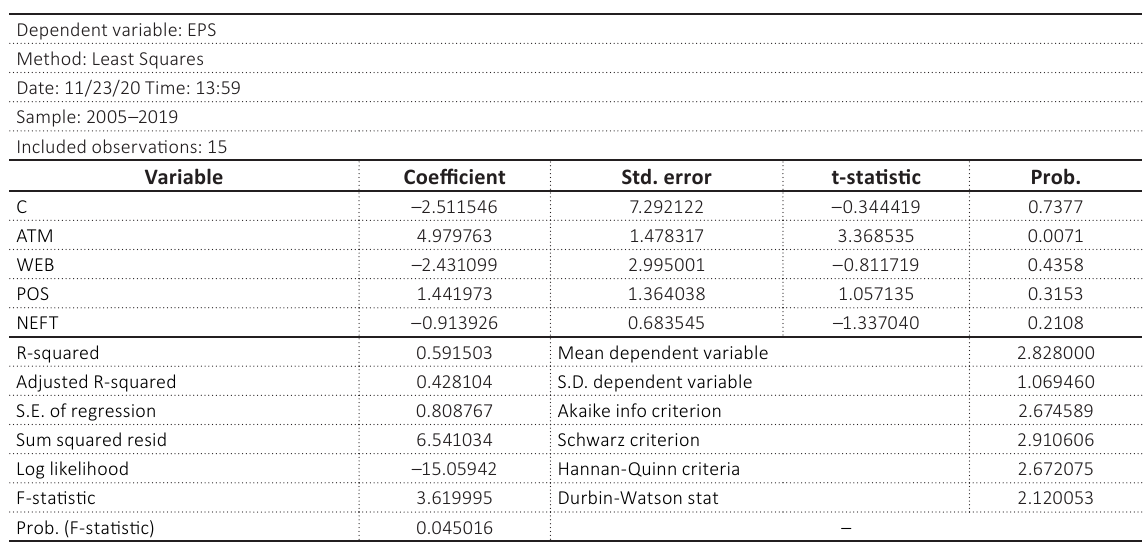
Table 4. Regression result for Hypothesis 1